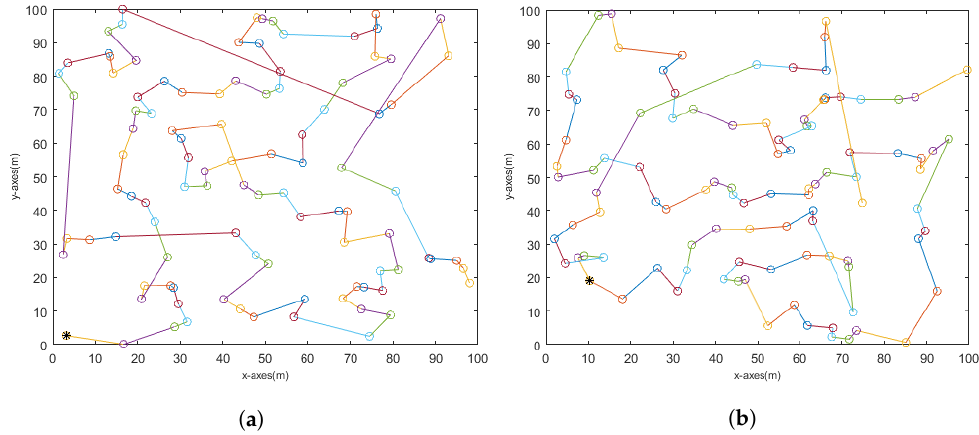
Figure 16. Single-chain formation: (nodes are represented using various colors, while (cid:107) is used to represent the CH) ( a ) D-Chain, ( b ) Q-Chain.